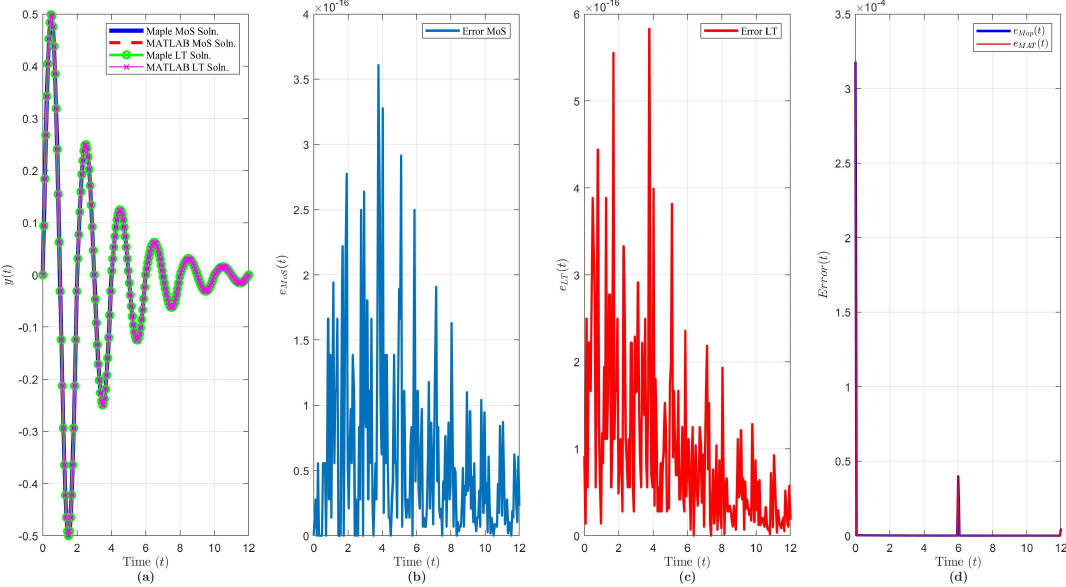
Figure 5. Solution results of Equation (22) over t ∈ [ 0,6 τ ] ( n = 500 terms): plot of ( a ) the solution y ( t ) via each method and software, ( b ) e MoS ( t ) , ( c ) e LT ( t ) , ( d ) e Map ( t ) and e MAT ( t )